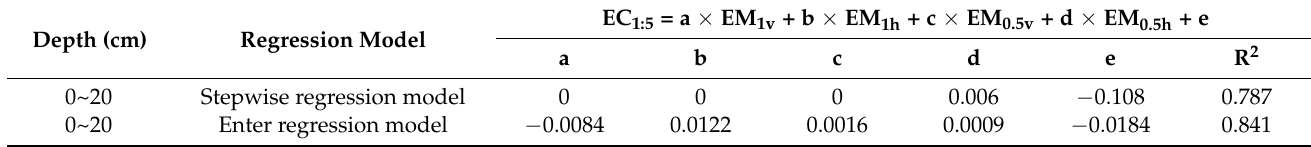
Table 1. Multiple linear regression models between soil electrical conductivity and EM data. Depth (cm) Regression